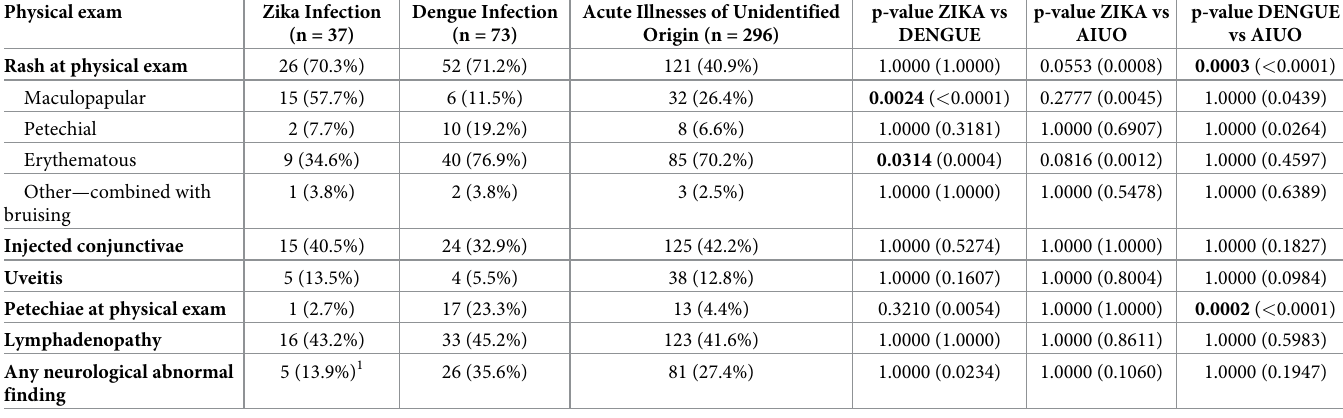
Table 3. Baseline distribution and characteristics of physical exam of patients 12 years and older seeking care within 7 days of onset due to acute episodes of fever and/or rash (N =